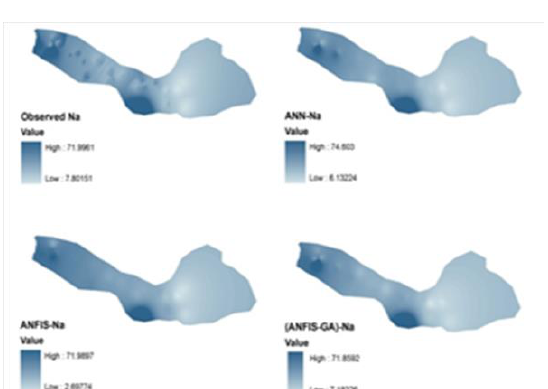
Figure 6. Observed and predicted (Na) for test period on Kerman’s aquifer.